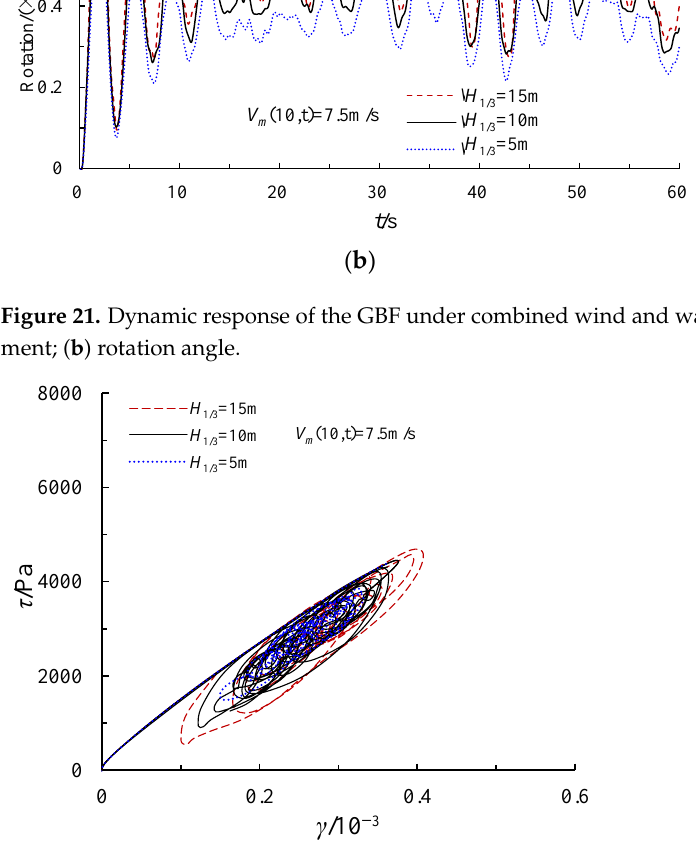
Figure 22. Soil stress–strain curves around the GBF for combined wind and wave loads.